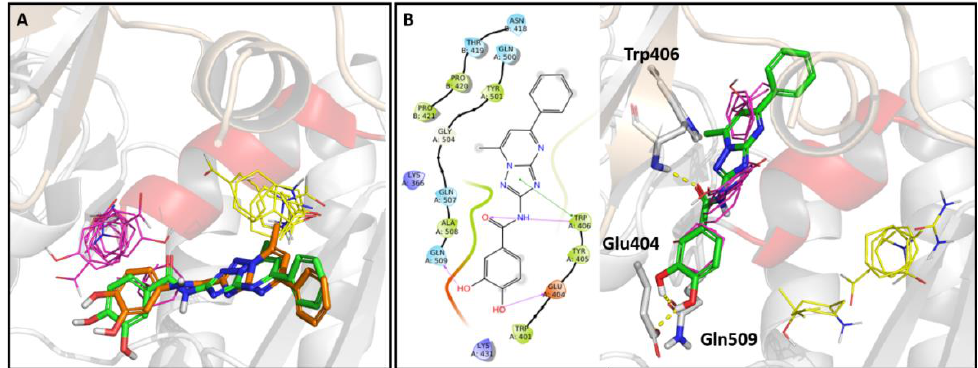
Figure 6. ( A ) Superimposition of docking poses for derivatives 13g (green) and 19g (orange) in 4IF7 protein. ( B ) 2D and 3D representation of 13g (green) binding mode produced by docking studies on 3LP1 structure. Magenta lines, Hs1 probes; yellow lines, Hs2 probes; red cartoon, α-helix 14.